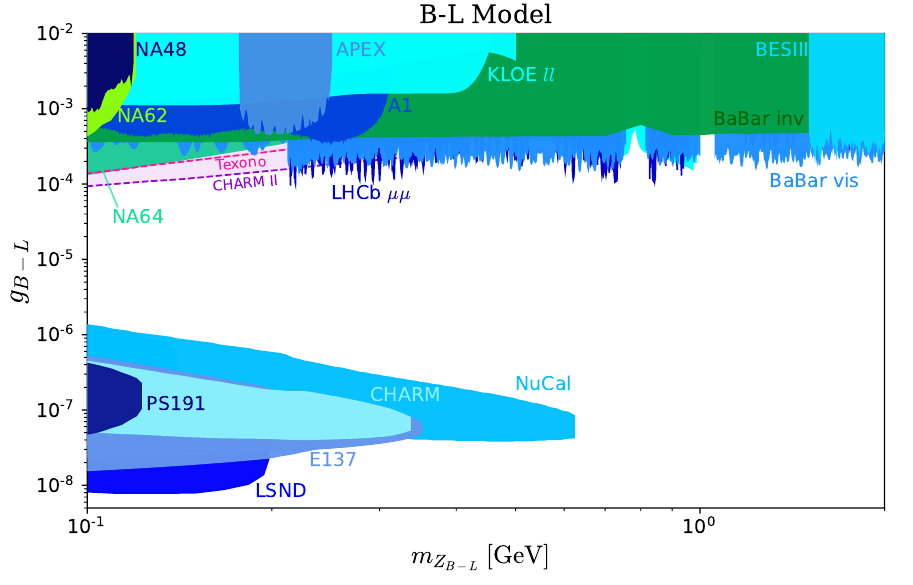
Figure 9 . Same as figure 8 but for the B − L model. In blue (green) the excluded regions for Z B − L decaying to charged lepton ( ν ¯ ν ) pairs. Beside the data already included in figure 8, here we also include data from KLOE in the µ + µ − final state [112, 113], from BaBar [109], NA62 [119] and NA64 [98–100] invisible searches, and from BESIII [110]. We also show with dashed lines the limits from the neutrino experiments Texono [123] (red) and CHARM-II [124] (purple) that were taken from [14].